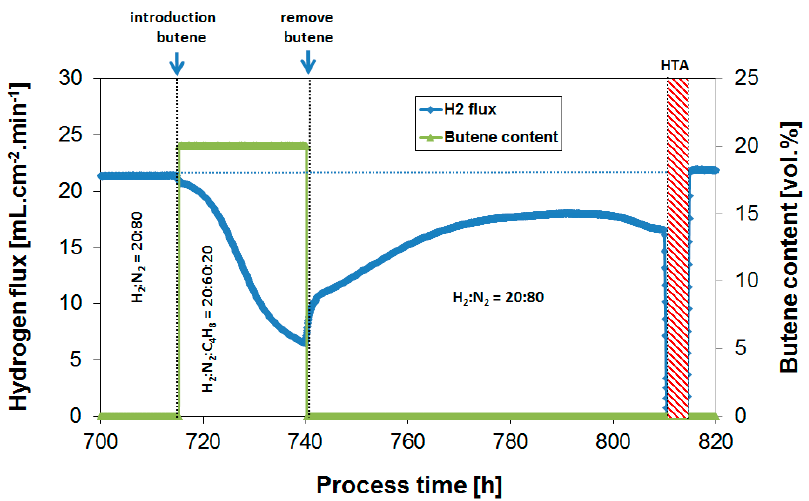
Figure 9. H 2 flux during prolonged exposure to butylene (20%) in a feed containing: H 2 :N 2 :C 4 H 10 = 20:60:20. Subsequent air treatment to regenerate the membrane performance. Temperature = 250 °C.